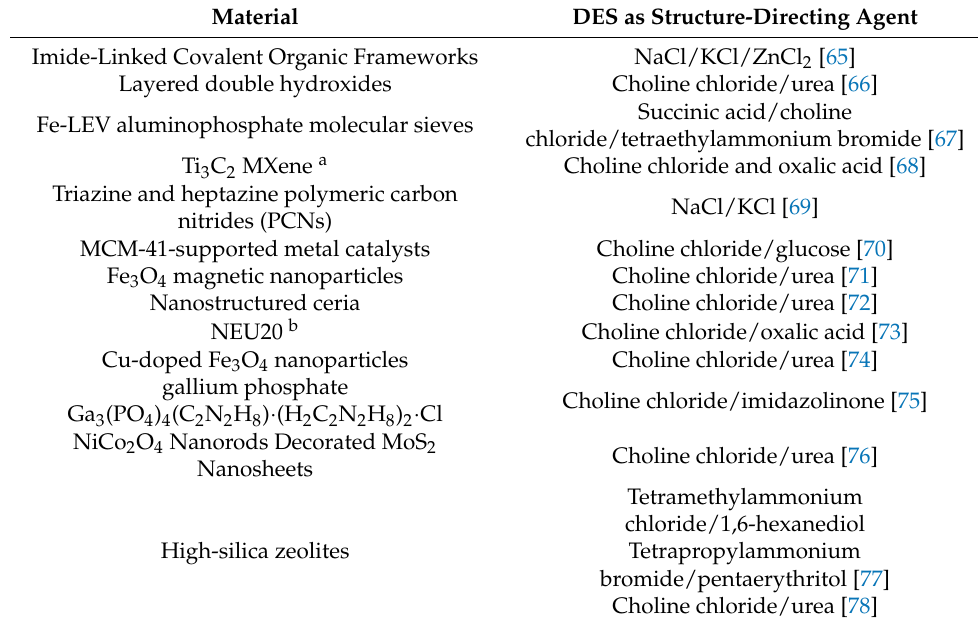
Table 4. Materials produced by ionothermal synthesis during the period